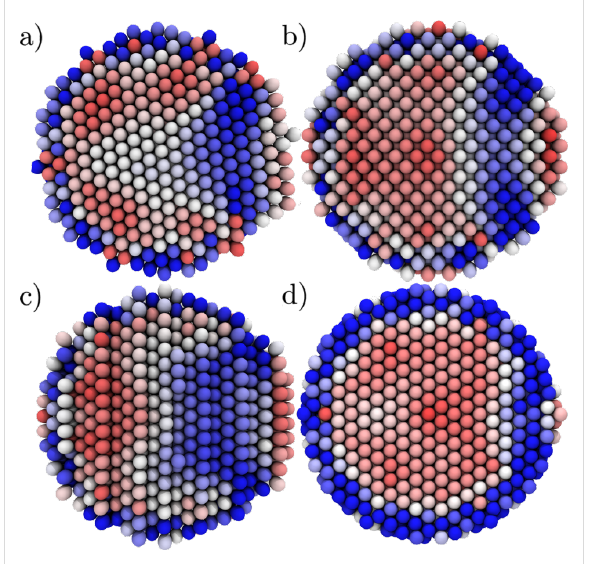
Figure 2: The maximum shear component of the atomic stress tensor expressed by the colouring of the atoms (colouring from red (= 0) to blue (>1 GPa)). (a–c) 15.6 Å orifice (displacive mode). (d) 11.6 Å orifice (surface amorphisation). (a) {111} planes oriented parallel to the extrusion direction. (b) {111} planes tilted with respect to the extrusion direction. (c) {111} planes oriented perpendicular to the extrusion direction. (d) {111} planes parallel (as in (a)) at the inset of surface amorphisation. To relieve the stress the systems have slightly rotated inside the force